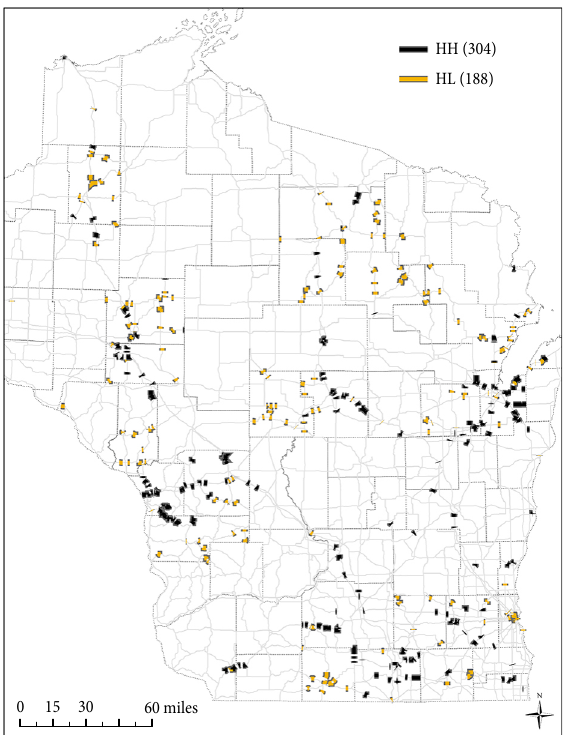
Fig. 1. Result of Global Moran’s I statistic showing distance bandwidth of peak clustering of weather-related crash rate in Wisconsin